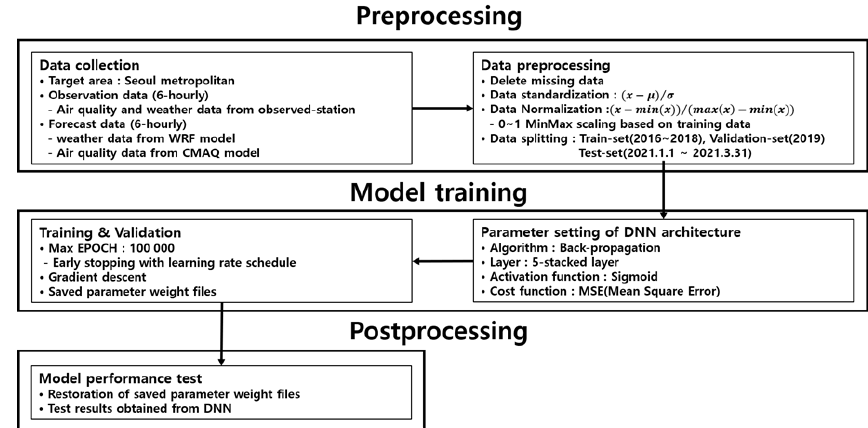
Figure 1. Flowchart of the PM 2 . 5 forecasting system based on the DNN